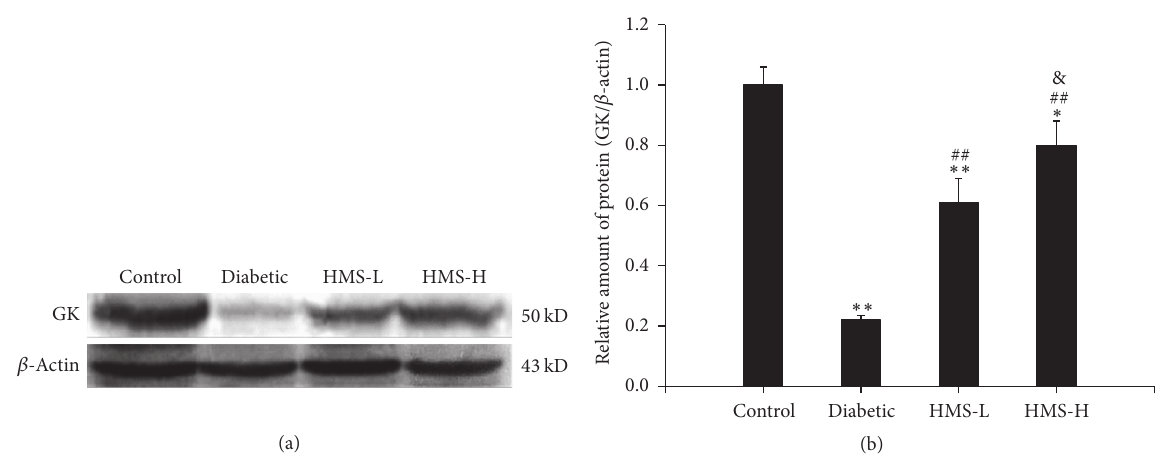
Figure 6: Effects of HMS5552 on the expression of GK protein in the rat liver. The expression of GK was detected by western blot (a), and the intensities of the bands were normalized against that of 𝛽 -actin (b). HMS-L group, low-dose (10mg/kg) HMS5552-treated diabetic group; HMS-H group, high-dose (30mg/kg) HMS5552-treated diabetic group. The data are expressed as the mean ± SD ( 𝑛 = 6 ). ∗ 𝑃 < 0.05 and ∗∗ 𝑃 < 0.01 , compared with the control group; ## 𝑃 < 0.01 , compared with the diabetic group; & 𝑃 < 0.05 , compared with the HMS-L group.